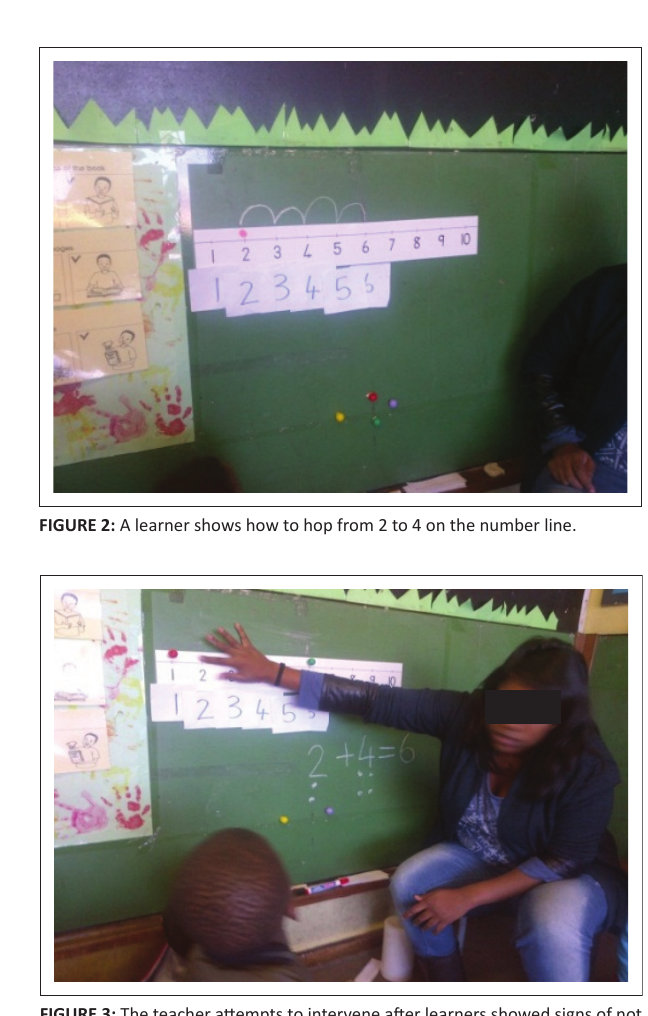
FIGURE 3: The teacher attempts to intervene after learners showed signs of not